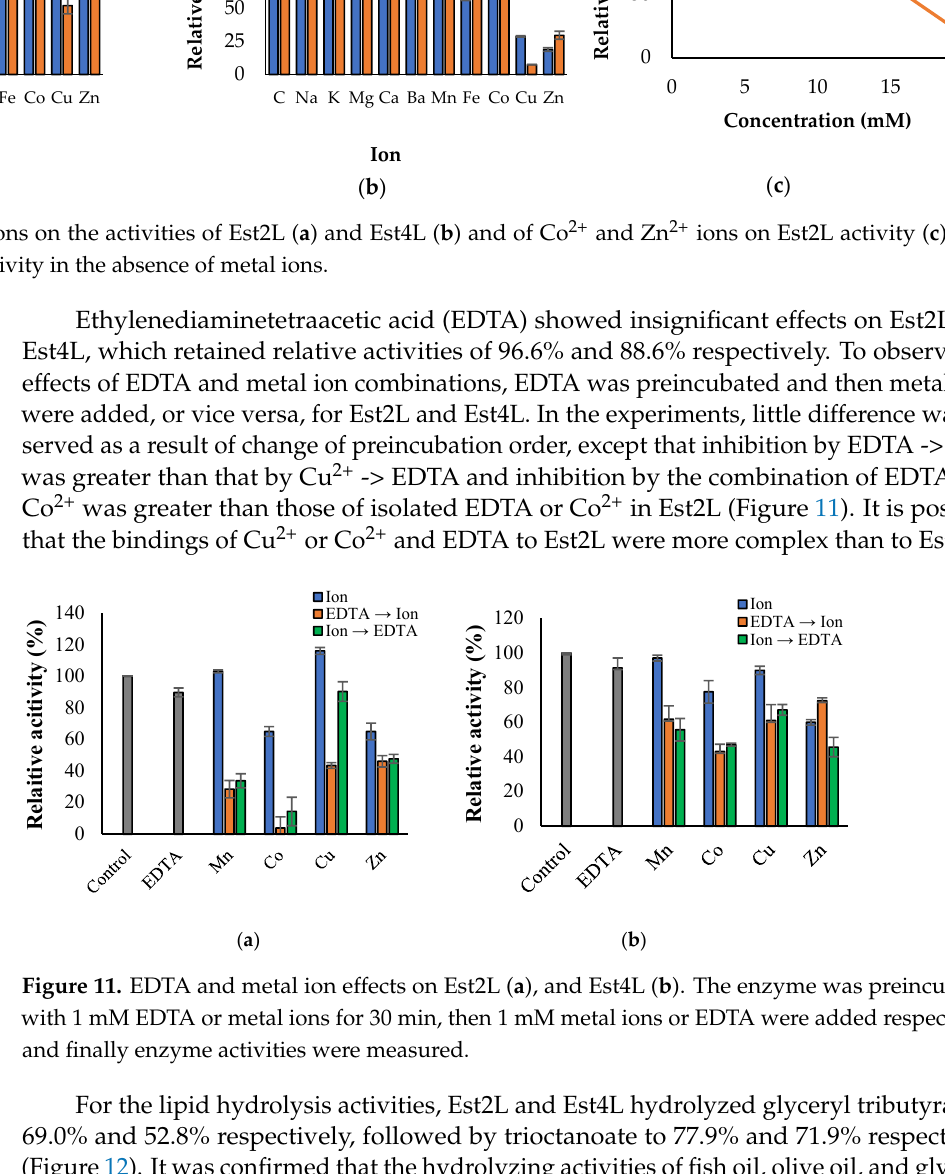
Figure 9. Effects of organic solvents, detergents, and PMSF on enzyme activities of Est2L ( a ) and Est4L ( b ). P.I., preincubated for 30 min.